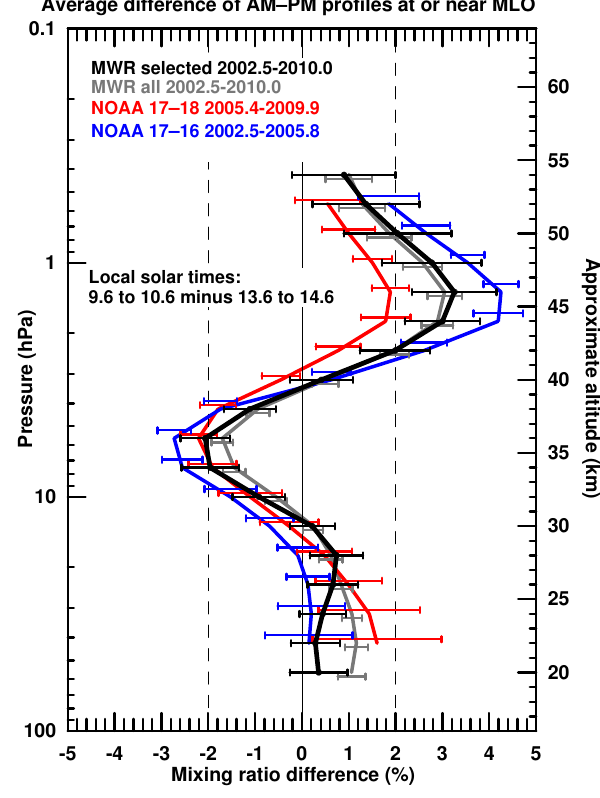
Figure 6. Average differences between morning (07:36 to 10:36LST) and nighttime reference (21:36 to 00:36LST) from UARS-MLS, SMILES, and MWR data. The data were normalized as described in Sect. 2.1. The SMILES profile shown in green and MWR profile shown in blue were averaged over the period 12 Oc- tober 2009 to 20 April 2010. The MWR profile shown in black was averaged over January 1995 to February 1998; the UARS-MLS profile shown in red over September 1991 to February 1998. The SMILES and UARS-MLS data have been convolved with the MWR averaging kernels. The error bars are calculated and displayed as de- scribed in the caption for Fig. 1.